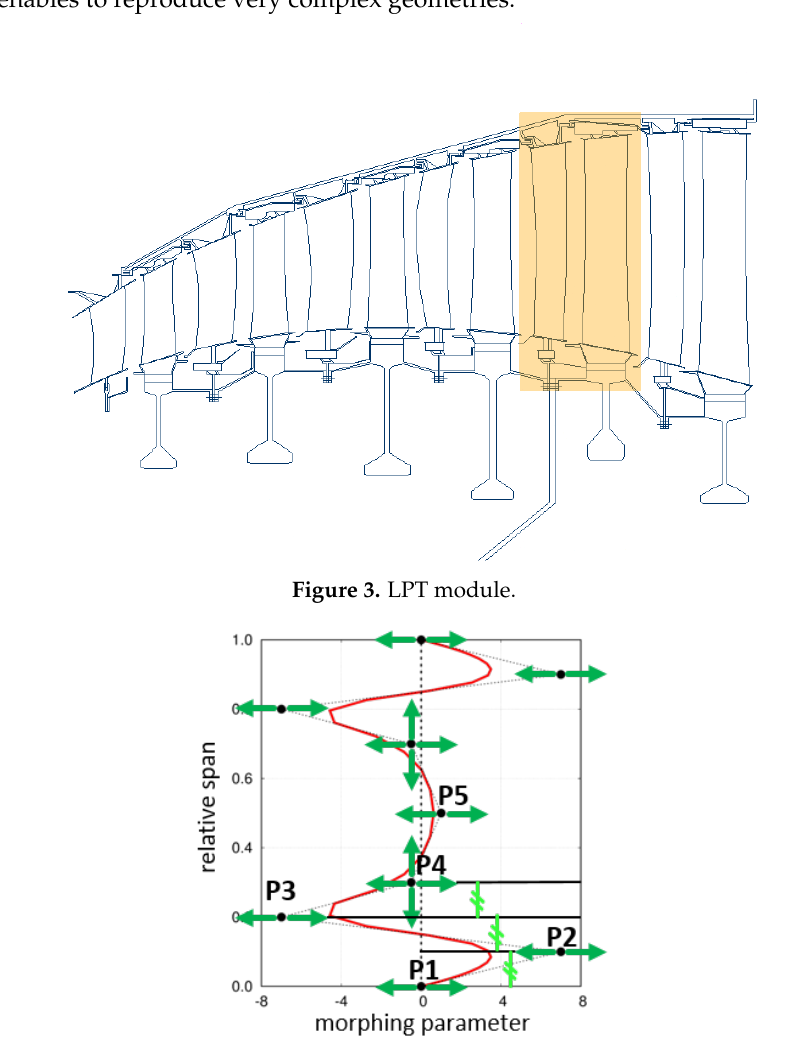
Figure 4. Span-wise parameterization of the morphing